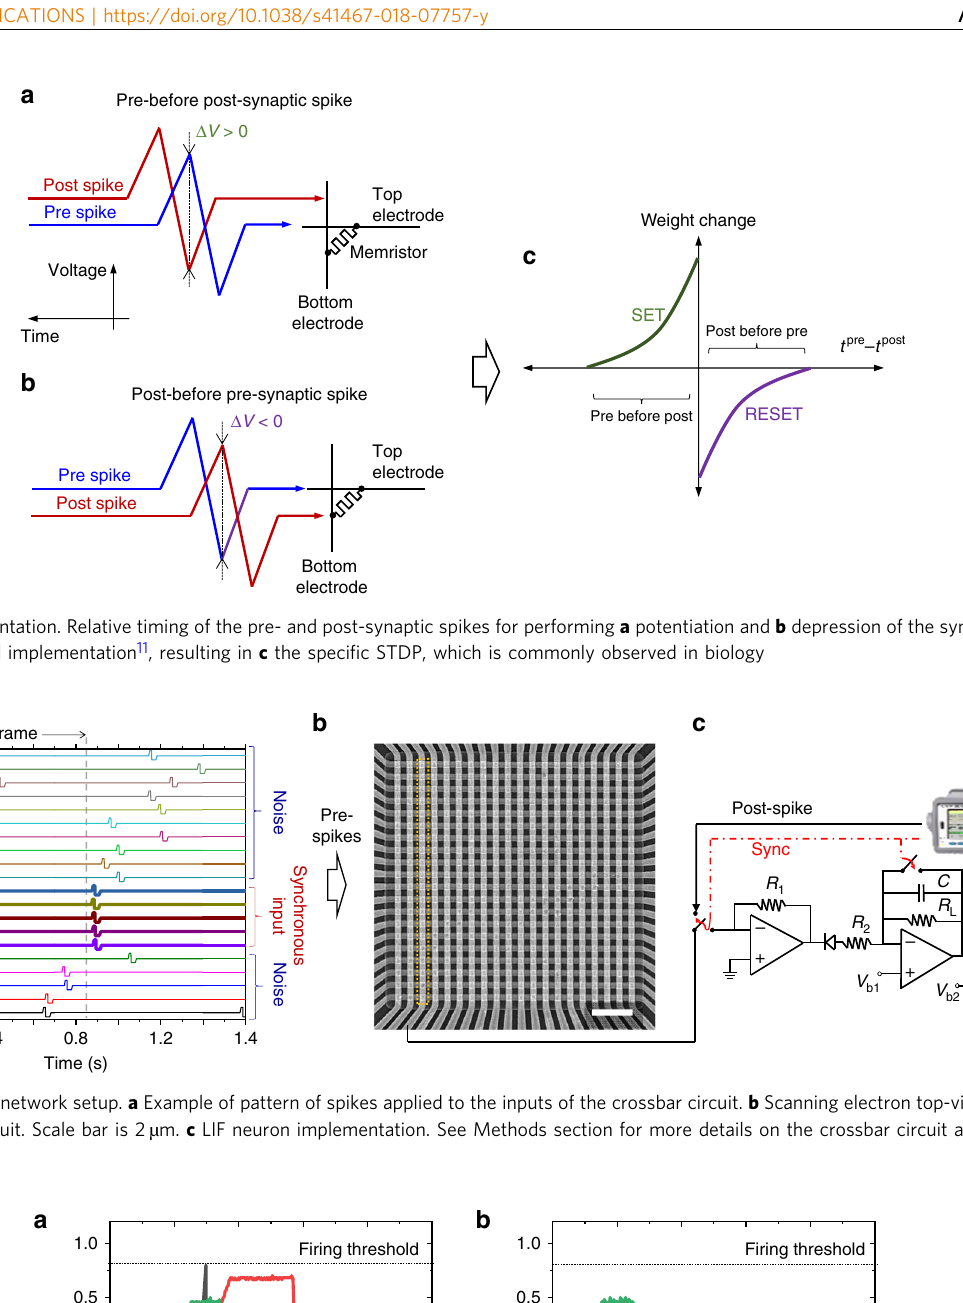
system for the fi rst set of experiments. The left panels show speci fi c frames of spiking input, while the right panels show the trajectory of each synaptic weight (during 20 epochs or a total of 1.68 s of spiking activity for Fig. 4e – g and 60 epochs for Fig. 4h), with thick/thin lines corresponding to the synchronized/